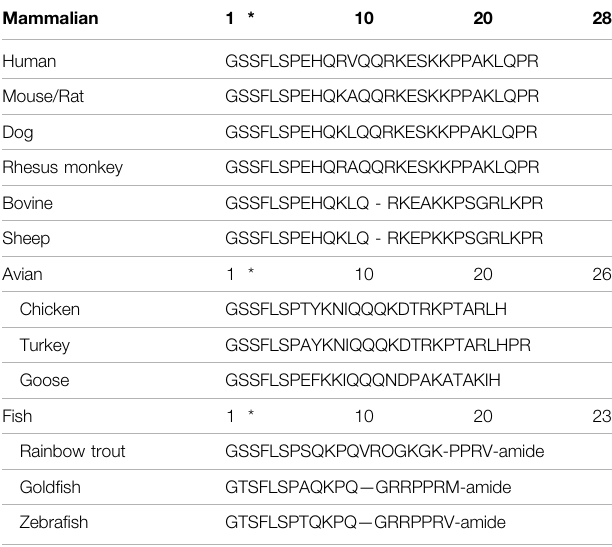
Foreachspecies,thethirdaminoacidoftheghrelinpeptidesequenceisaserineresidue and is the location for acyl-modi fi cation (indicated by asterisks). As shown, there is homology between the NH 2 -terminal sequences of ghrelin from these vertebrate